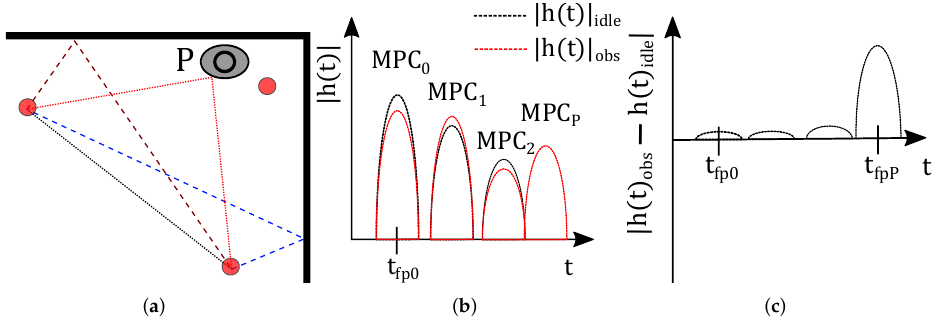
Figure 2. Principle of MSR for UWB CIR measurements. ( a ) Concept of MSR. ( b ) CIR measurement with idle and non-idle target area. ( c ) CIR